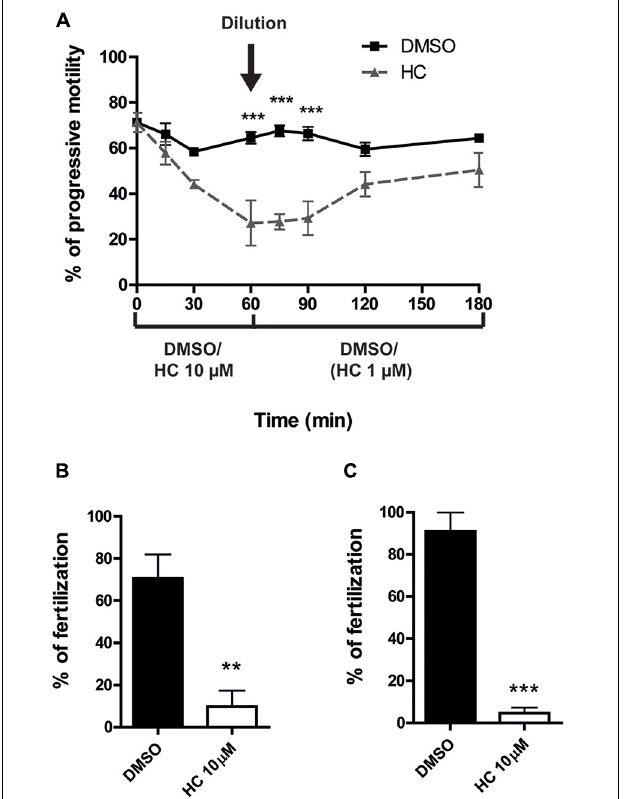
FIGURE 4 | In vitro fertilizing ability of sperm exposed to HC before capacitation. (A) Percentage of progressive motility analyzed as a function of incubation time for sperm incubated for 60 min in a high, non-capacitating concentration in a medium containing 10 µ M HC or DMSO as control, then diluted in medium alone to reach both a capacitation sperm concentration and a 1 µ M HC concentration, and finally incubated for an additional 120 min. Samples collected at different time points were analyzed by observation under light microscopy (400x). (B,C) Sperm incubated under capacitating conditions (after dilution) were coincubated with COC for 3 h (B) or with ZP-free oocytes for 1 h (C) . At the end of incubations, fertilization was evaluated. Eggs were considered fertilized when at least one decondensing sperm nucleus or two pronuclei were observed in the egg cytoplasm and the percentage of fertilized eggs was determined. Data are mean ± SEM of at least n = 3 independent experiments; ** p < 0.005; *** p < 0.0005 vs.